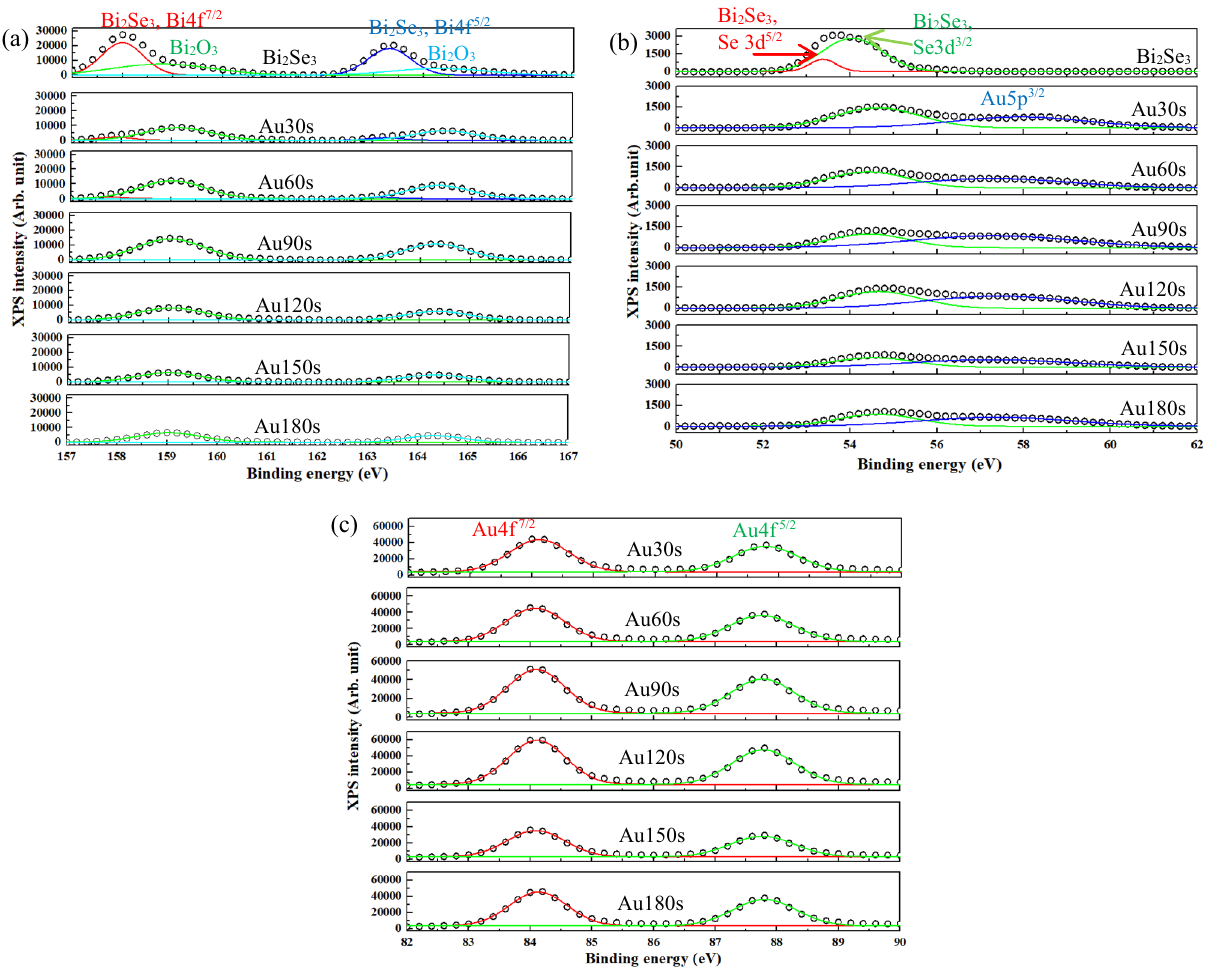
Figure 4. XPS spectra of ( a ) Bi 4f., ( b ) Se 3d, and ( c ) Au 4f. of the Au-decorated Bi 2 Se 3